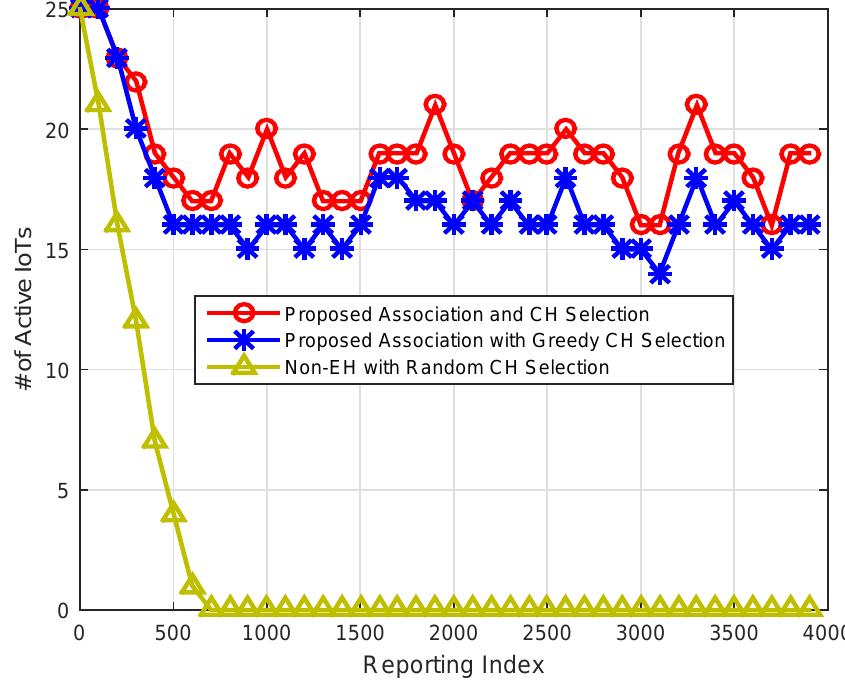
Figure 9. Comparison based on alive IoTs across different